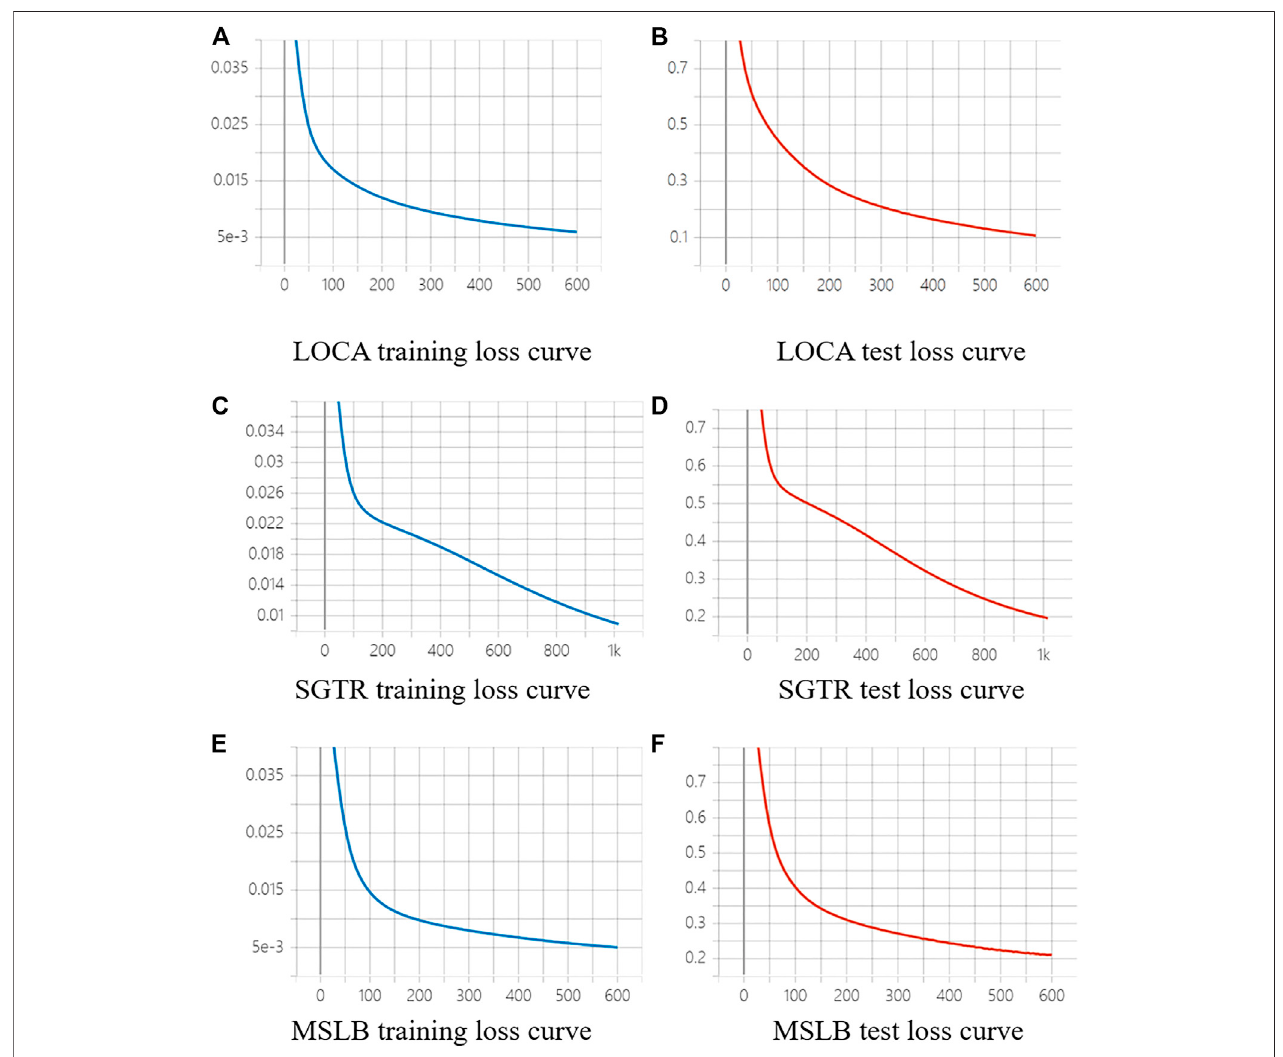
FIGURE9| LosscurvesofthreeneuralnetworksforthesecondarydiagnosismodelofSBN-ANN. (A) LOCAtraininglosscurve (B) LOCAtestlosscurve (C) SGTR training loss curve (D) SGTR test loss curve (E) MSLB training loss curve (F) MSLB test loss curve.